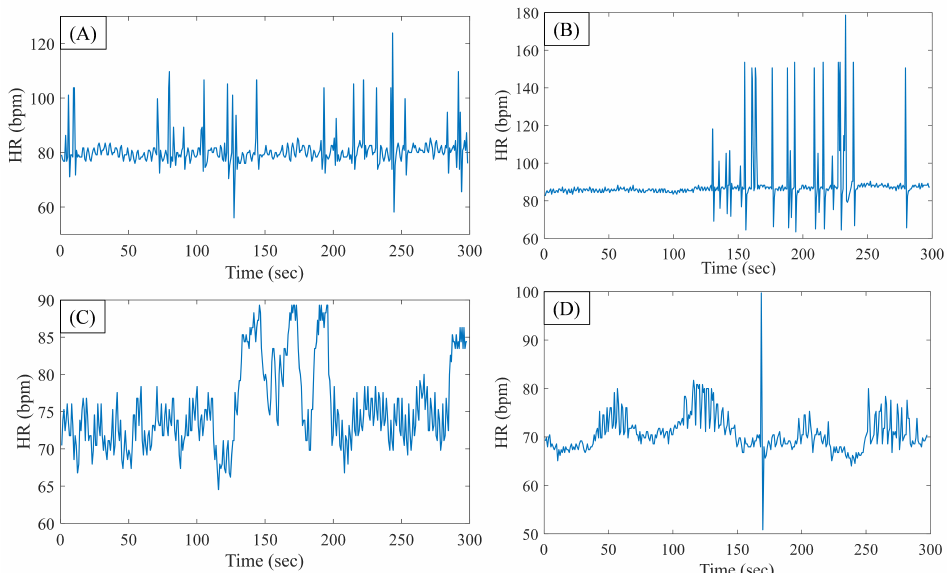
Figure 2. Representative 5-min heart rate signal, which is immediately prior to the AF onset: ( A ) from the CinC data set and ( B ) from the MIMIC III data set. Representative 5-min heart rate signal for control group: ( C ) from the CinC data set and ( D ) from the MIMIC III data